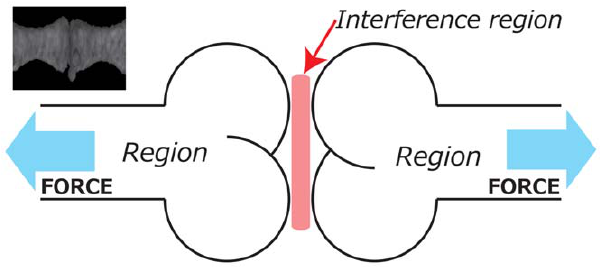
Figure 3. Schematic overview of the proposed segmentation method. On the upper left is a CT image of a joint of a mouse’s